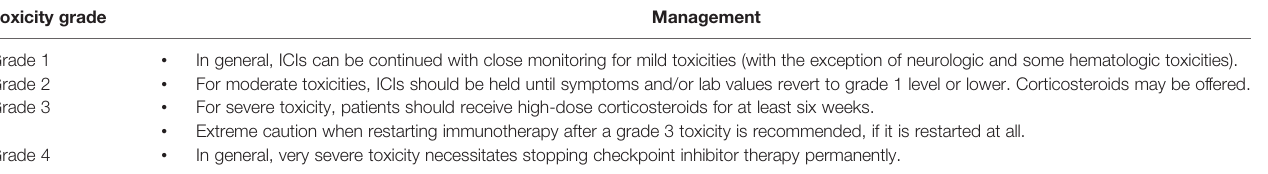
TABLE 4 | Management of ICIs based on toxicity levels according to the current guidelines (50,